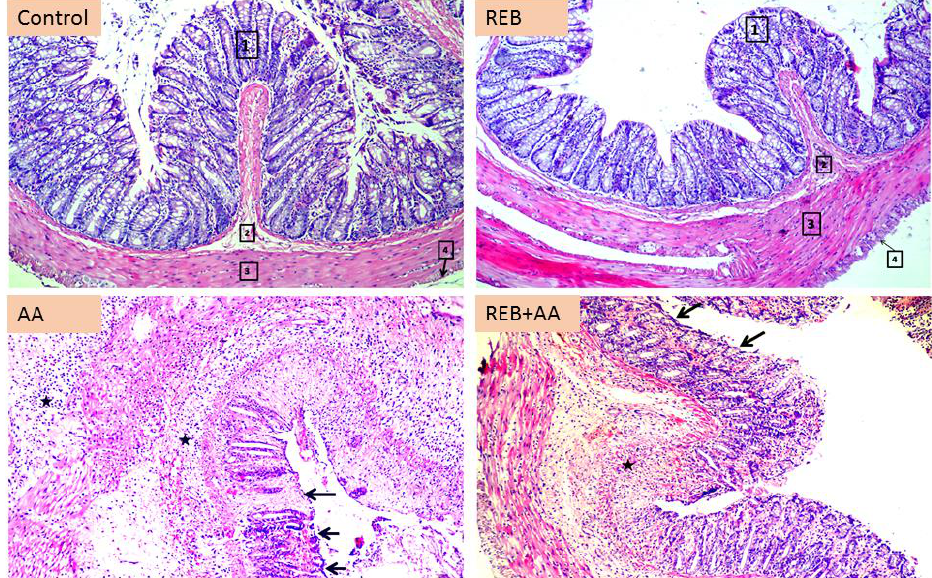
Figure 2. Rebamipide administration counteracts the colonic microscopical damage induced by acetic acid (H–E stain; 100× lower magnification). The photomicrographs at the lower magnification reveal that both the control group and rebamipide (REB)-treated control group demonstrated intact structures of all layers of the colon including the mucosa [1], submucosa [2], muscularis [3], and serosa [4]. On the other hand, the acetic acid (AA) group showed ulcerated surface epithelium (arrow) and severe submucosal infiltration (star). Rebamipide administration to the AA-challenged group attenuated the pathological alterations; however, some colonic areas showed few sites of ulcerated surface epithelium (arrow) and a moderate submucosal infiltration (star). REB, rebamipide; AA, acetic acid.